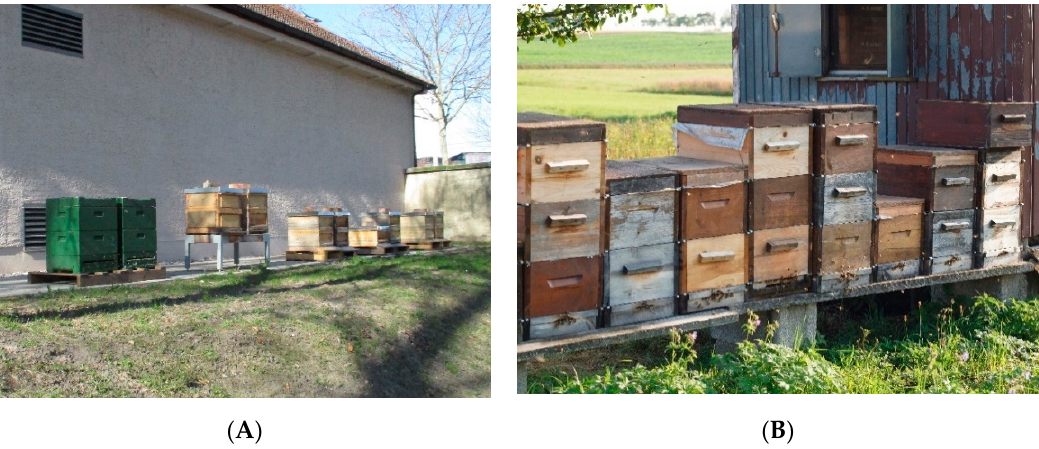
Figure 2. ( A ) Apiary in April 2019: colonies with two brood chambers in wooden Zander hives and polystyrene Segeberger Classic hives, standing in pairs of two. © Julia Dittes. ( B ) Apiary with Zander hives with one or two brood chambers and honey supers on top, standing next to each other. © Heike Aupperle-Lellbach.